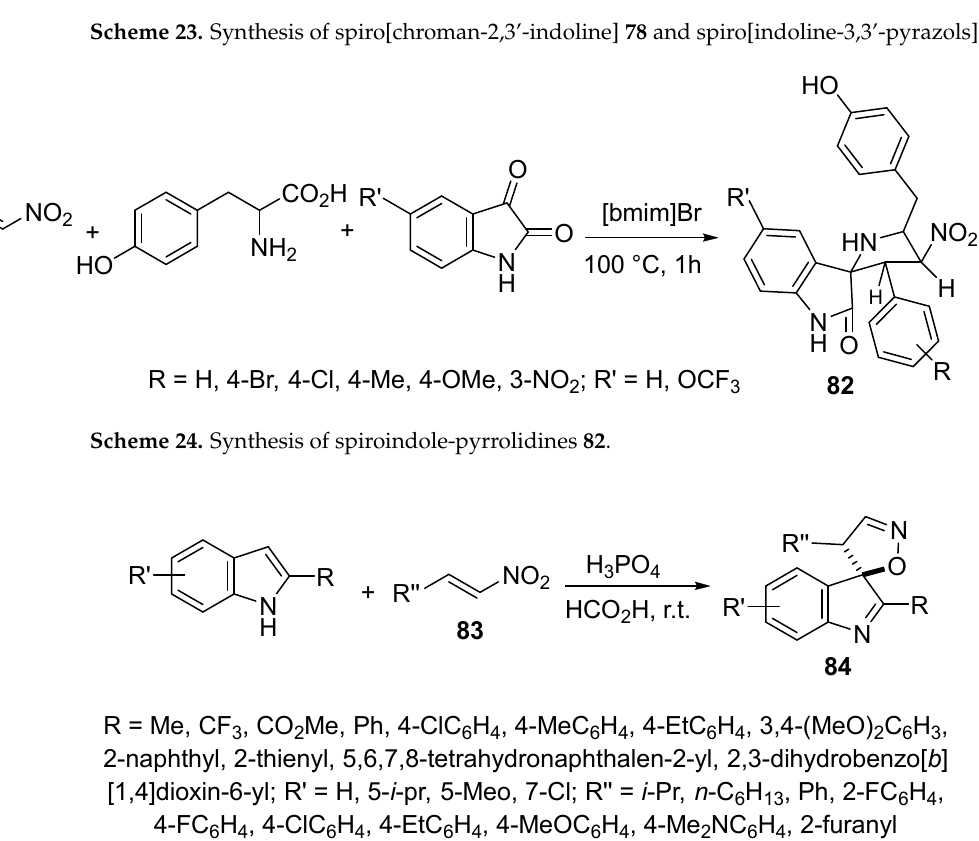
respectively). The chiral configuration of compound 82 was not identified by the authors